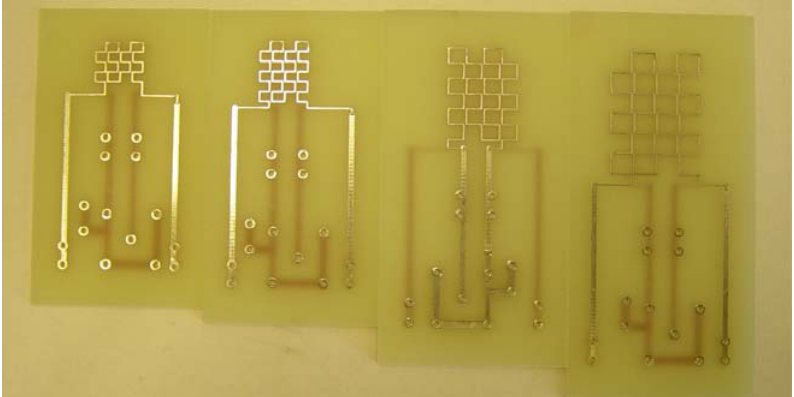
Figure 4. Fabricated mesh type sensors.